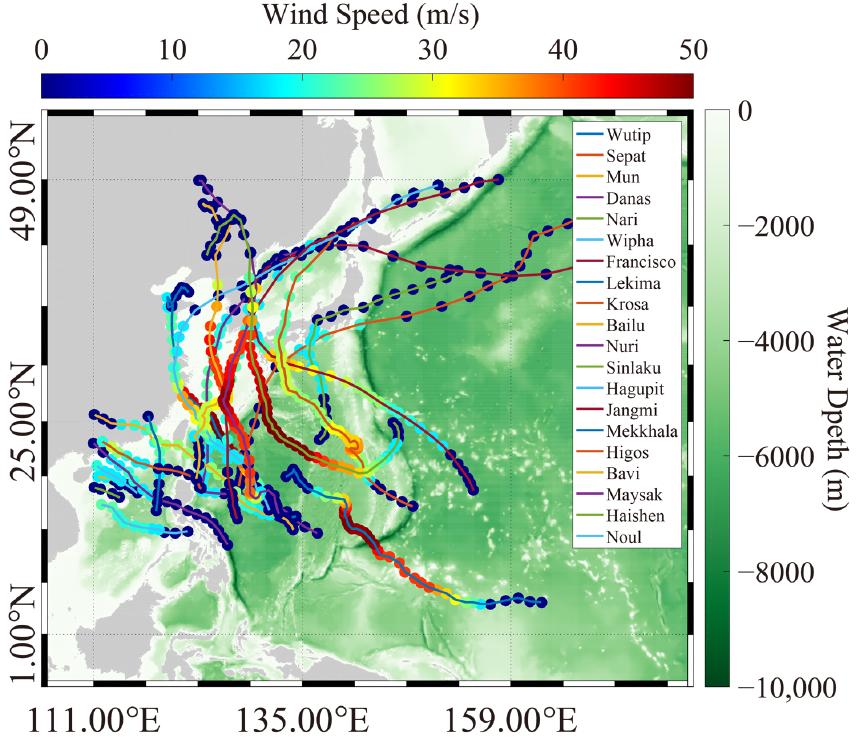
Figure 3. The tracks of 20 available typhoons with SWIM wind and wave products, overlaid by the water depth from the General Bathymetry Chart of the Oceans (GEBCO). Table 1. The geographic locations of buoys in China Seas used in this